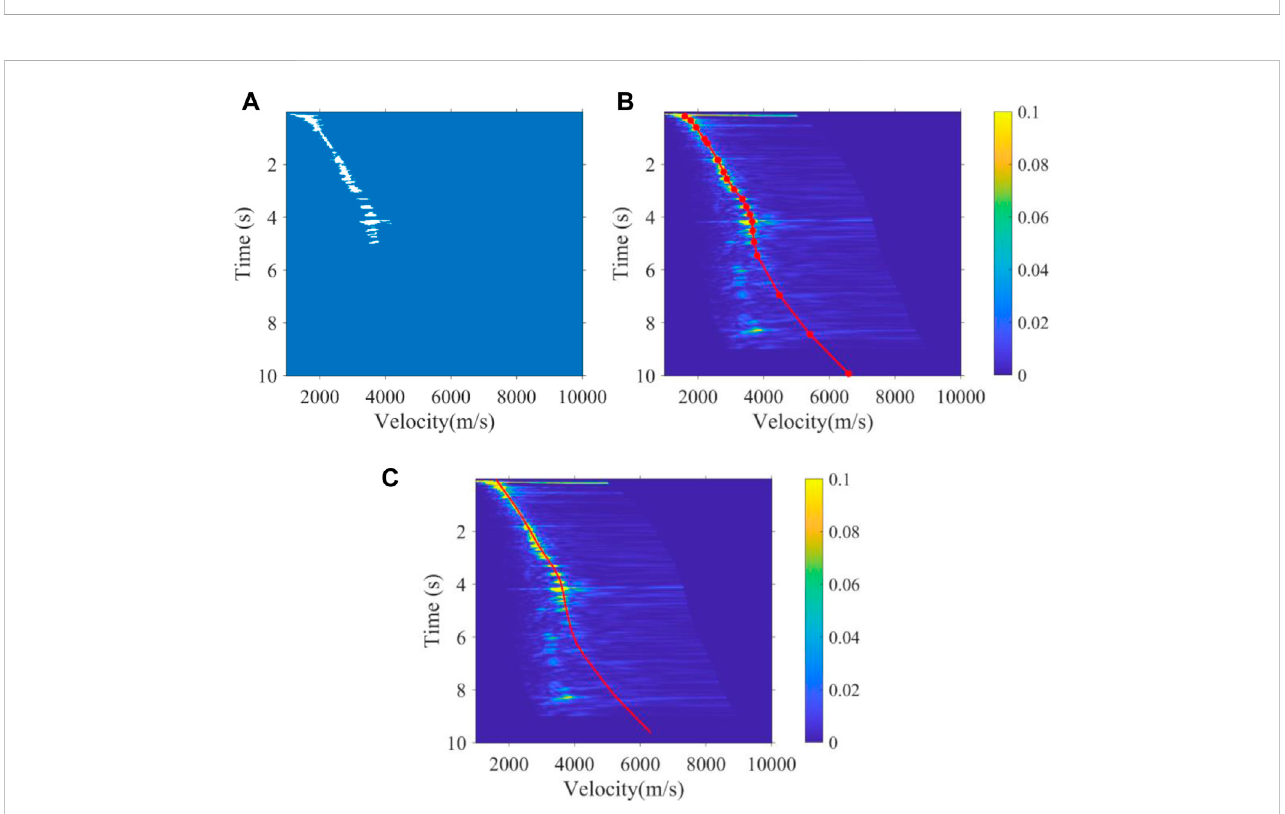
FIGURE 5 3900th velocity spectrum with multiple developments in 6 – 9 s of real data. (A) Segmentation result, (B) intelligent picking result by using the method proposed, and (C) manual picking result by semblance analysis.